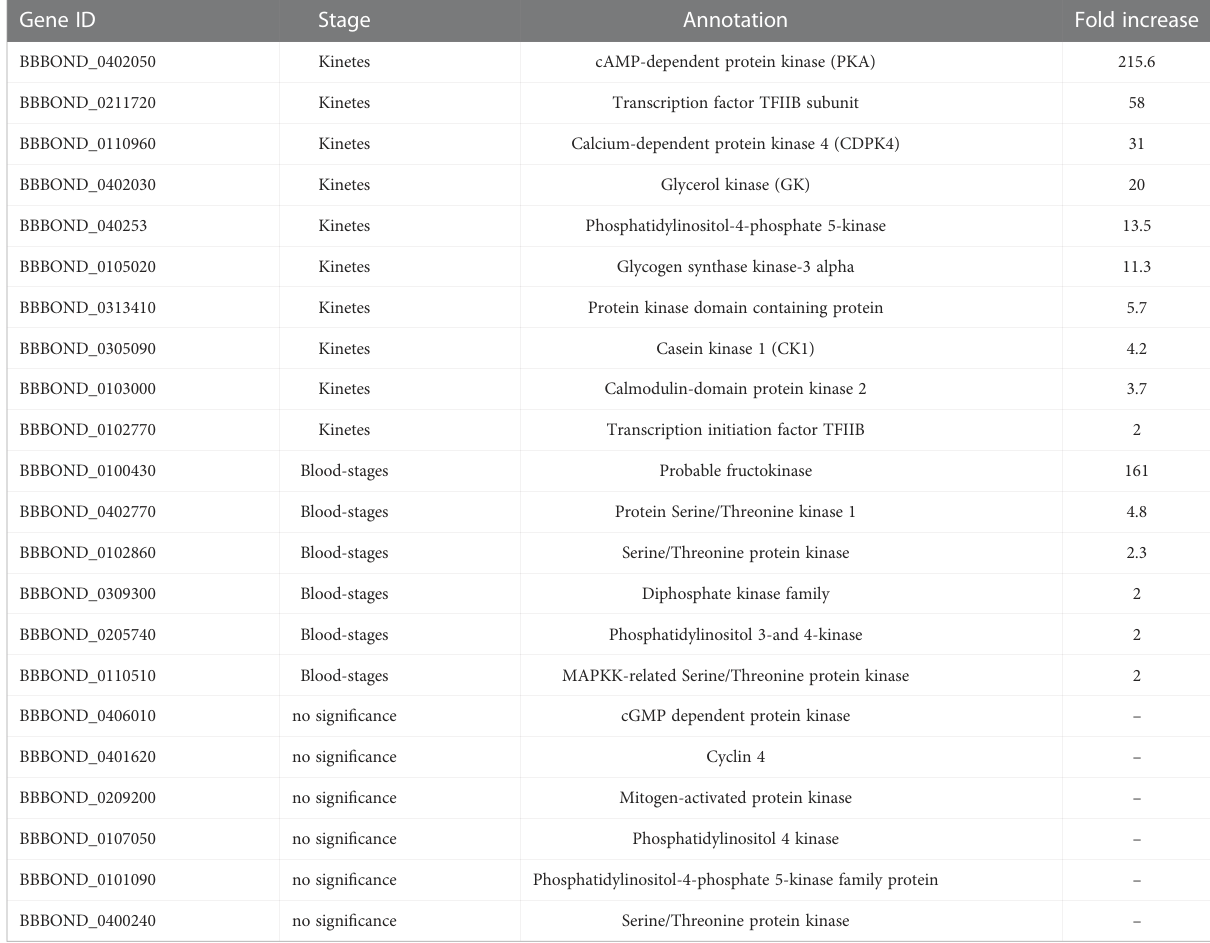
TABLE 7 Virulence genes in B. bigemina kinetes and